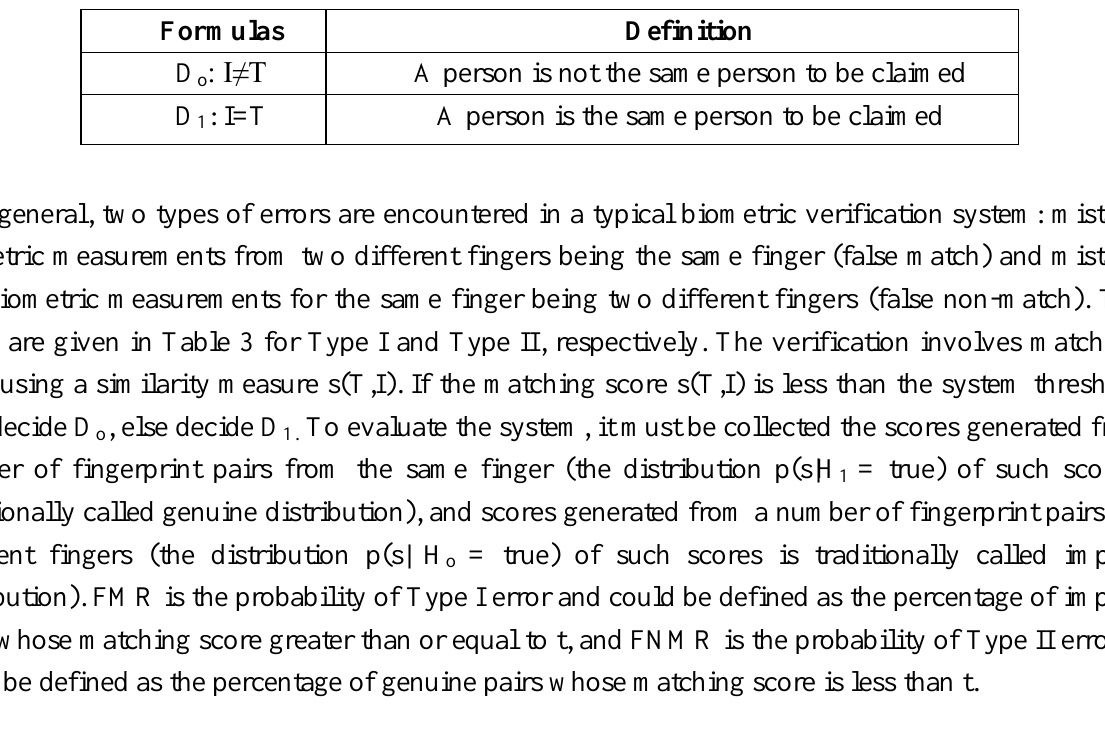
Table 2. Decision